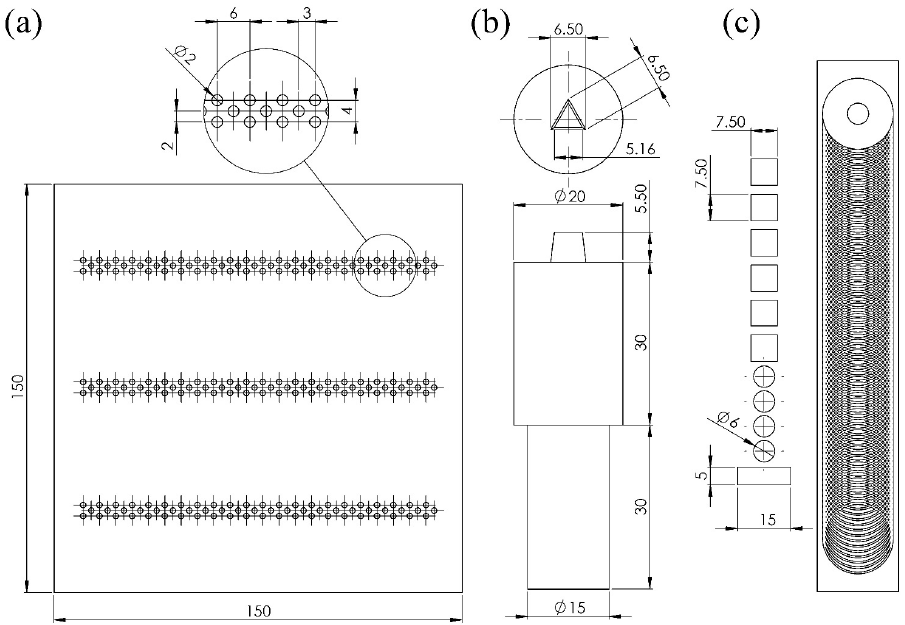
Figure 1. The dimensions of ( a ) holes patterns, ( b ) FS processing tool, and ( c ) samples for characterization and their places. All dimensions in mm. (ø is the diameter)